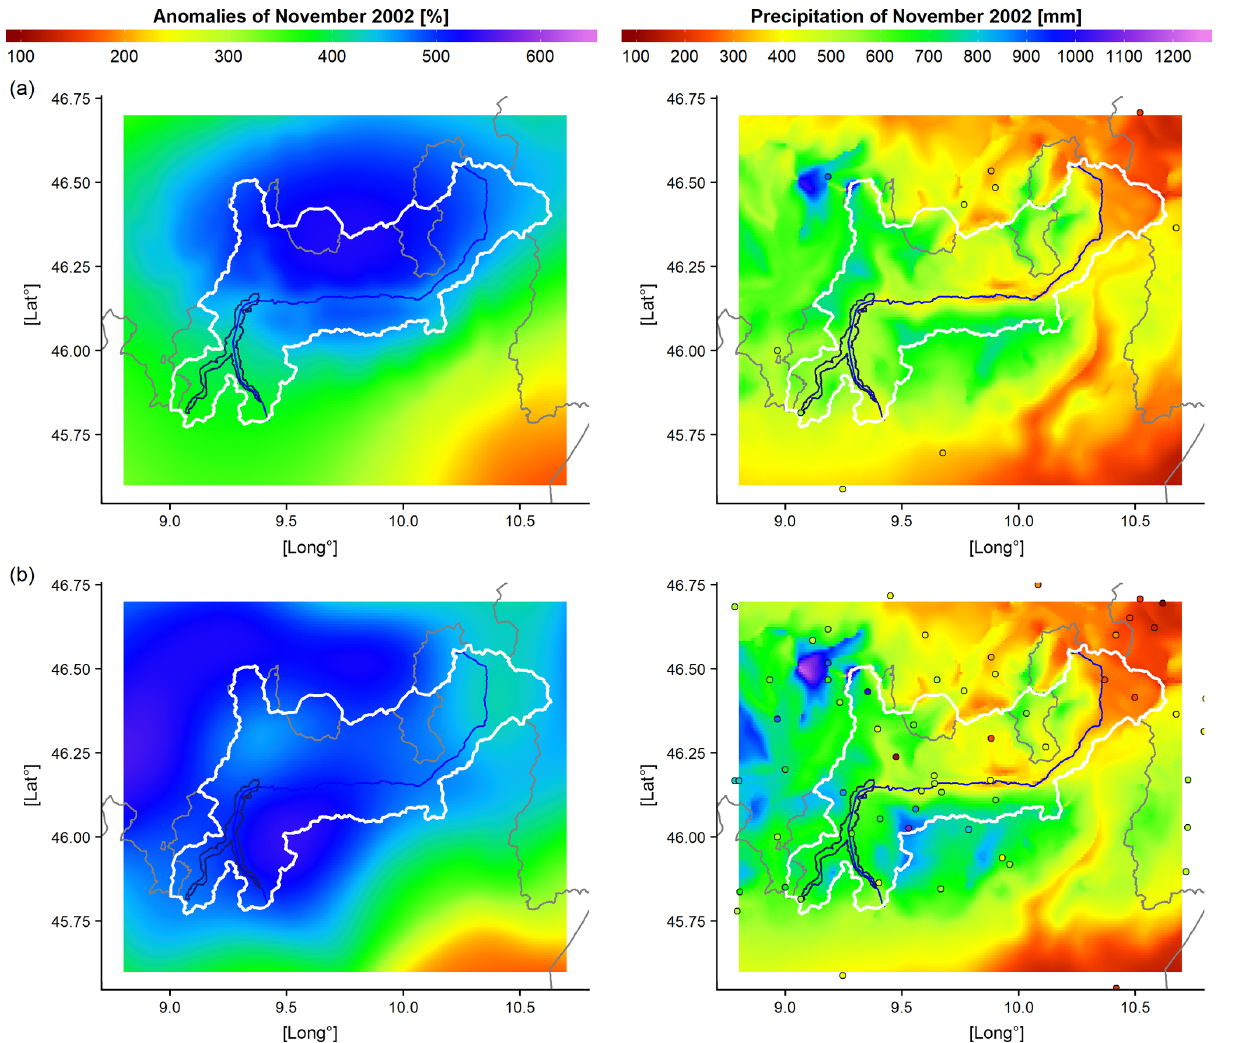
Figure 5. Monthly anomaly and precipitation distribution over the domain in November 2002 obtained by considering station availability in (a) 1882 and (b) 1922. Points represent station locations with available data and they are coloured in accordance to measured